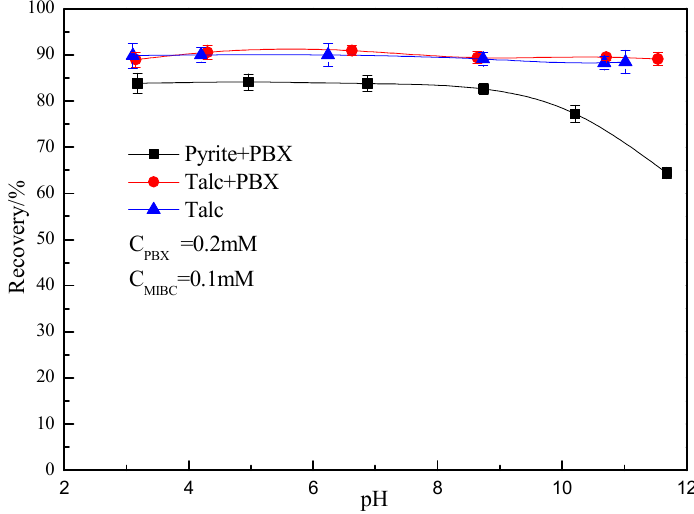
Figure 3. Effect of pH on the microflotation recovery of pyrite and talc.